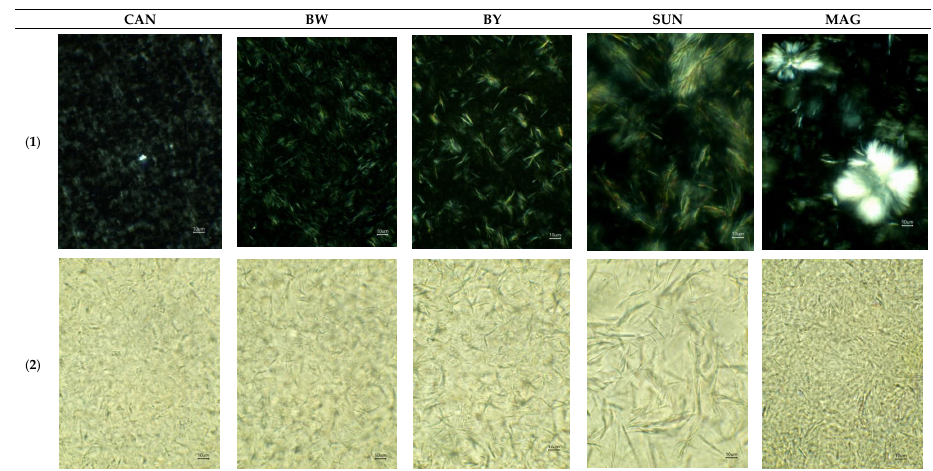
× magnification, obtained by